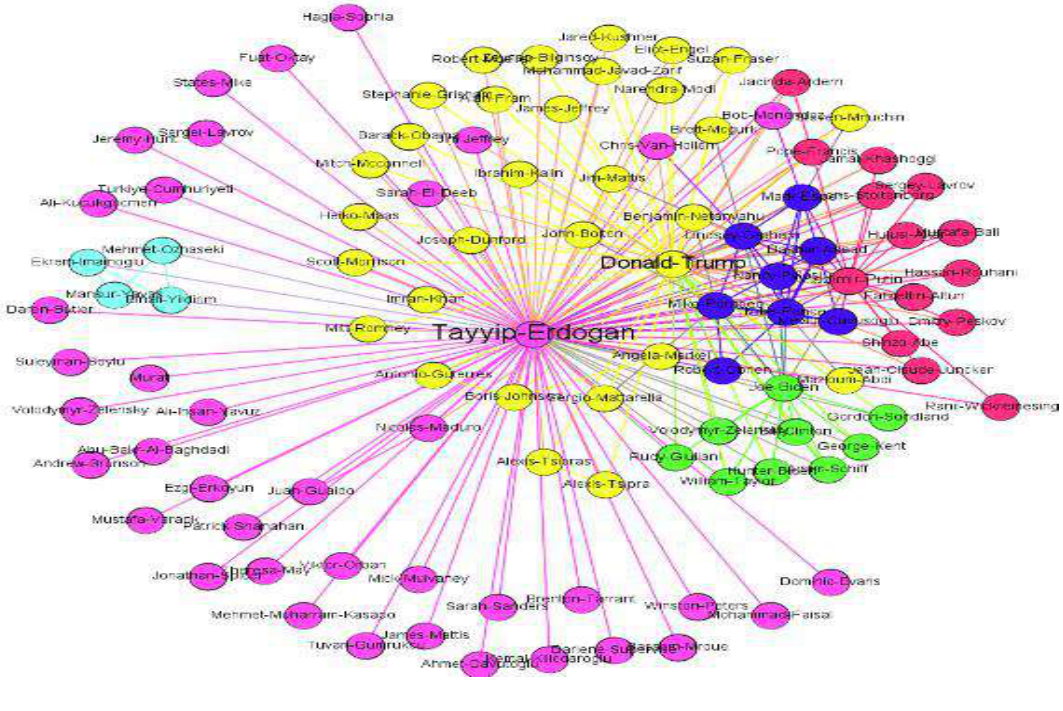
Figure 18: Modularity 2019 (Source: Authors ‟ depiction)